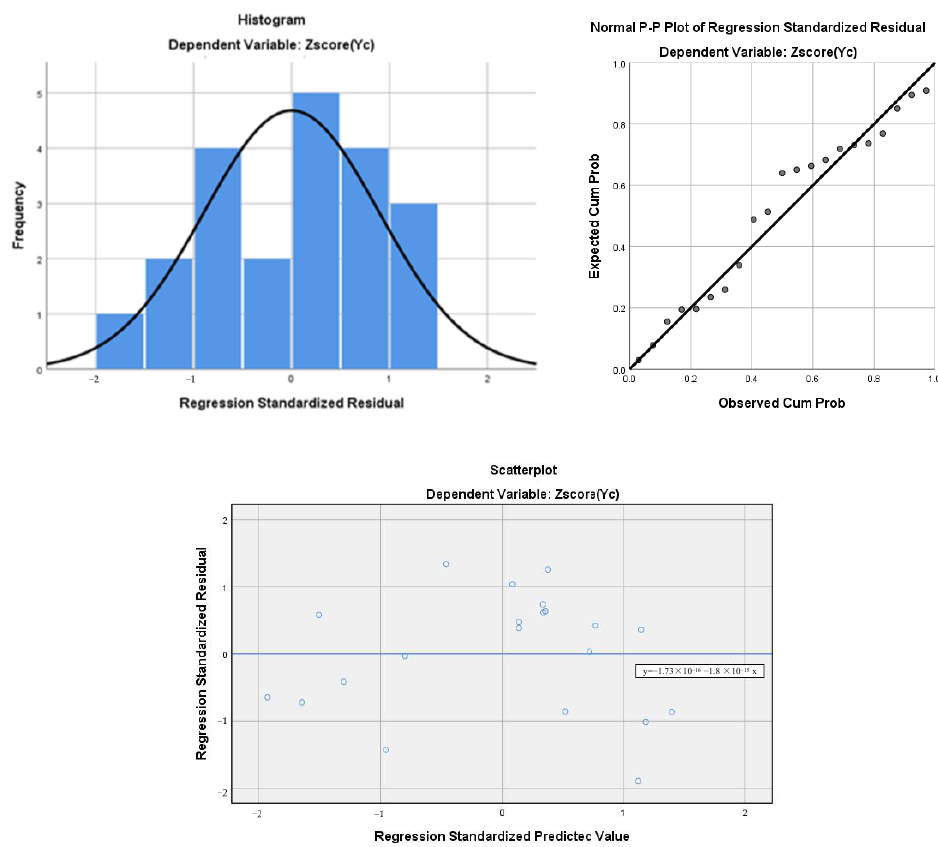
Figure 6. The standardized residual analysis. Table 6. Multiple linear backward stepwise regression analysis based on a principal component analysis (B and Beta represent the regression coefficient; Std. represents standard error; Tol.